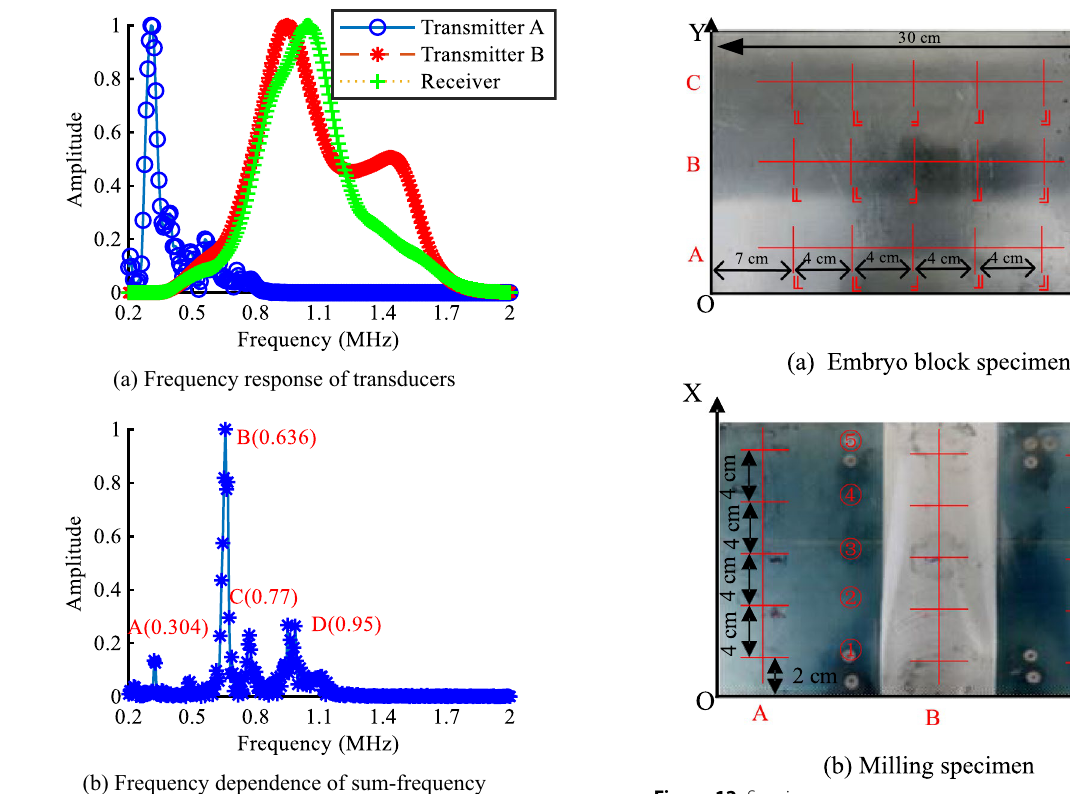
Figure 11 Sweep curve of frequency response